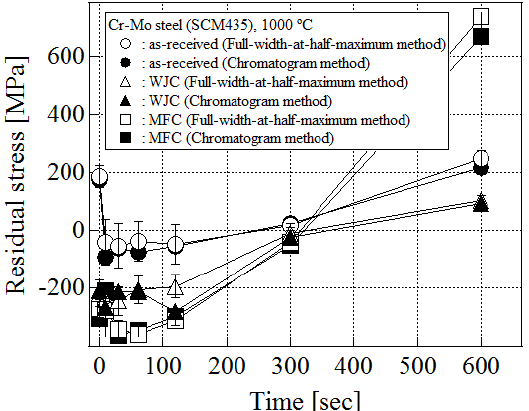
Figure 5. Time dependence of residual stress for Cr–Mo steel (SCM435).